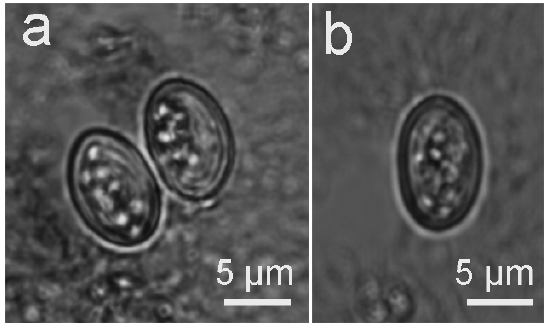
Figure 2. Light micrograph of Sarcocystis masoni sporulated oocyst and sporocysts in the feces of experimentally infected dogs (unstained). ( a ) Sporulated oocyst. ( b ) Sporocyst.